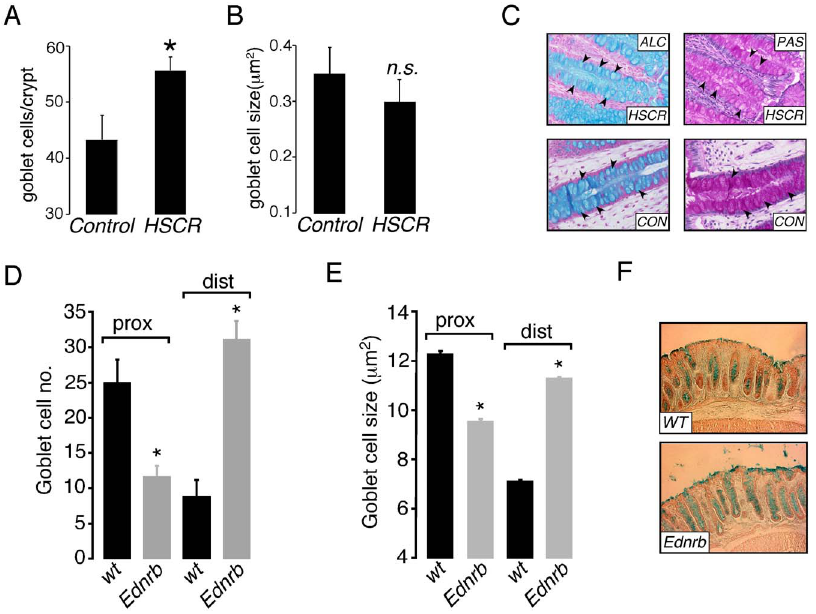
Figure 2. Colon goblet cells in human HSCR and Ednrb 2 / 2 mice. A. Summary graph showing goblet cell density in colonic crypts from control (n=4) and HSCR patients (n=13). B. Summary graph showing goblet cell size ( m m 2 ) in colonic crypts from control (n=4) and HSCR patients (n=13). C. Representative images showing Periodic Acid Schiff (PAS) and Alcian blue (ALC) staining of colonic crypts from biopsies obtained from control (CON) and HSCR patients. D. Summary graph showing goblet cell density in colonic crypts from proximal (prox) and distal (dist) colon from WT (n=5) and Ednrb 2 / 2 mice (n=5). E. Summary graph showing goblet cell size ( m m 2 ) in colonic crypts from WT (n=5) and Ednrb 2 / 2 mice (n=5). F. Representative images showing Alcian blue staining of goblet cells from distal colon from WT and Ednrb 2 / 2 mice. *p , 0.05, n.s.=not significant.